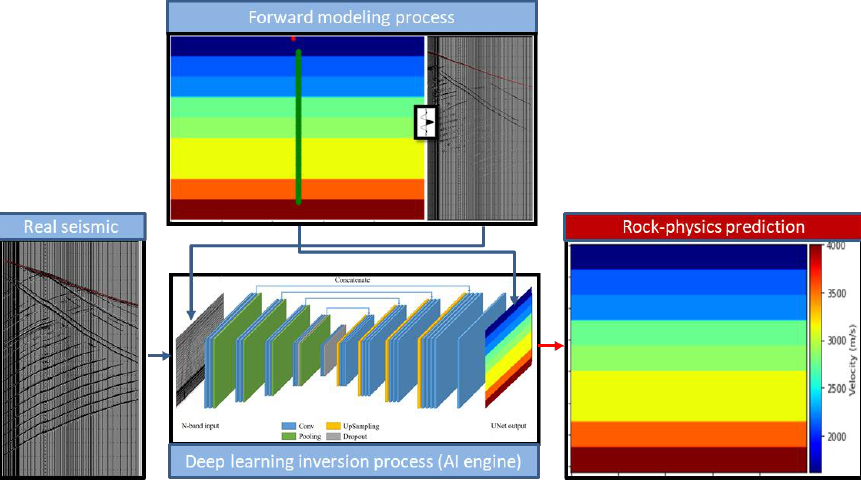
Figure 5—Stage 01-forward modeling products are the materials for deep learning network model training; an AI engine will be saved to predict rock-properties from real seismic and VSP